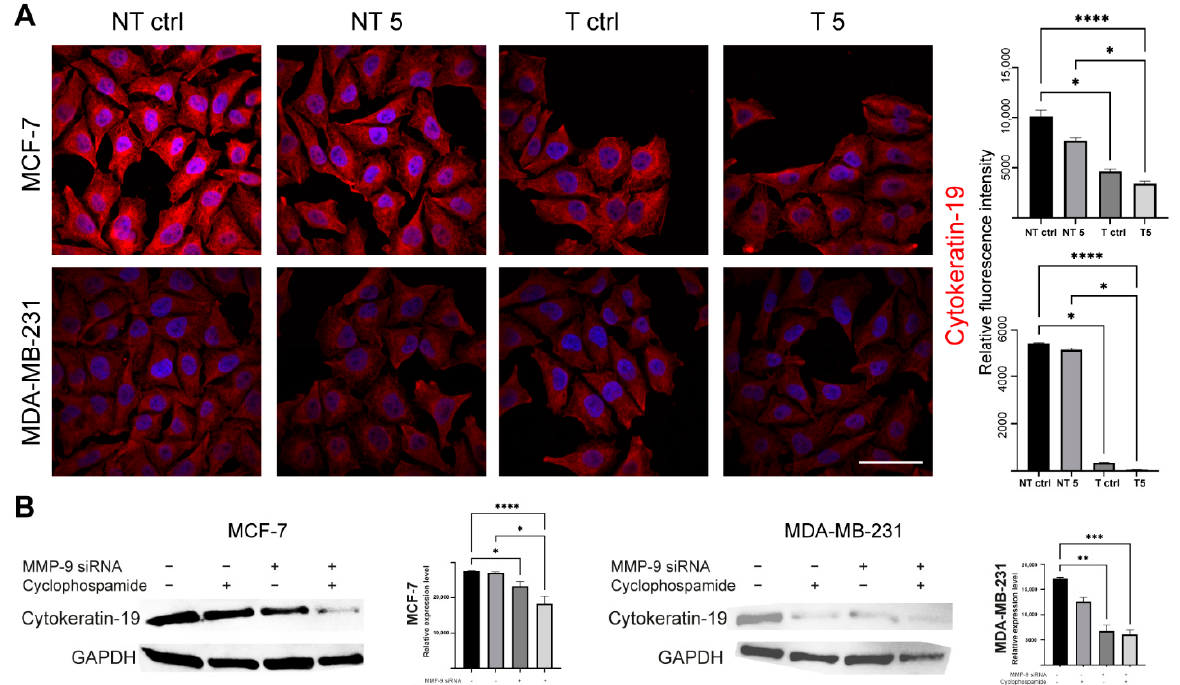
Figure 8. The effect of MMP-9 downregulation on Cytokeratin 19 (CK19) level. NT—non-transfected cells, T—cells transfected with MMP-9 siRNA, NT5 and T5 non-transfected and transfected cells treated with 5 mM cyclophosphamide for 24 h. ( A ) Immunofluorescent imaging of Cytokeratin 19 (red), and nuclei (blue), and cytometric relative fluorescence intensity of Cytokeratin 19, Bar = 50 μ m. ( B ) The Western blot analysis of Cytokeratin 19 and densitometric relative measurement of the Western blot experiments. Statistically significant differences were marked with ‘*’ p ≤ 0.05, ‘**’ p ≤ 0.01, ‘***’ p ≤ 0.001, and ‘****’ p ≤ 0.0001 (Kruskal-Wallis test).